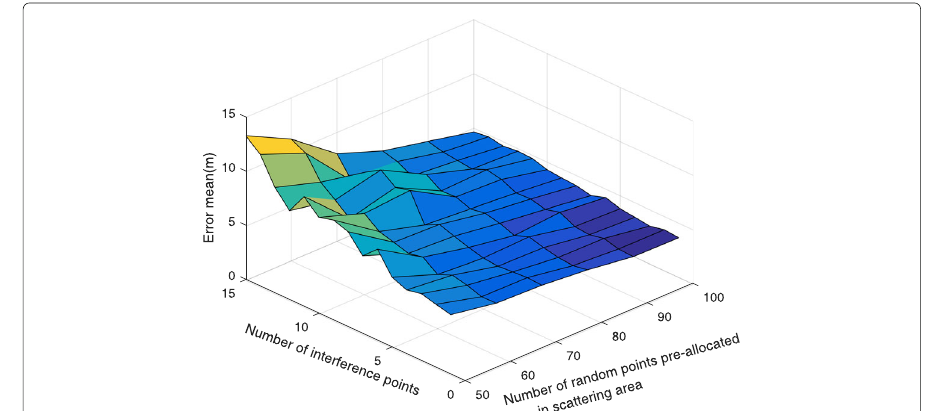
Fig. 9 Influence of interference points and pre-assigned random points on the